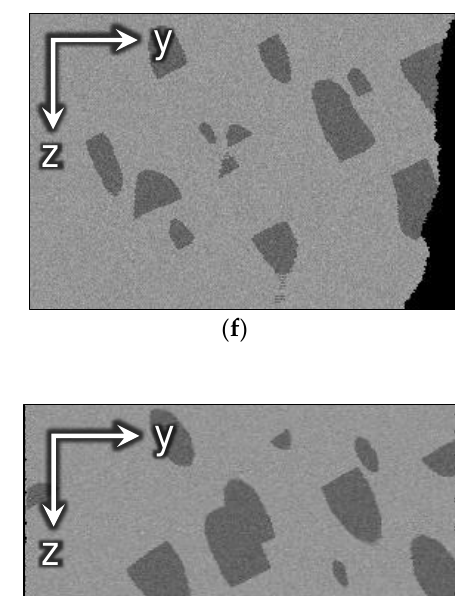
Table 1. Alignment metrics for the synthetic